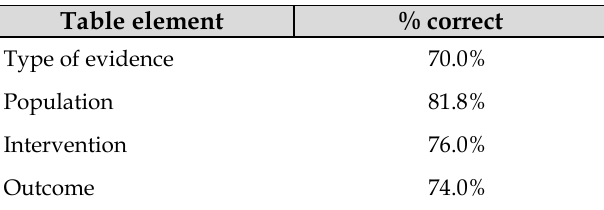
Table 3 Percent of correctly identified study elements in student posters Table